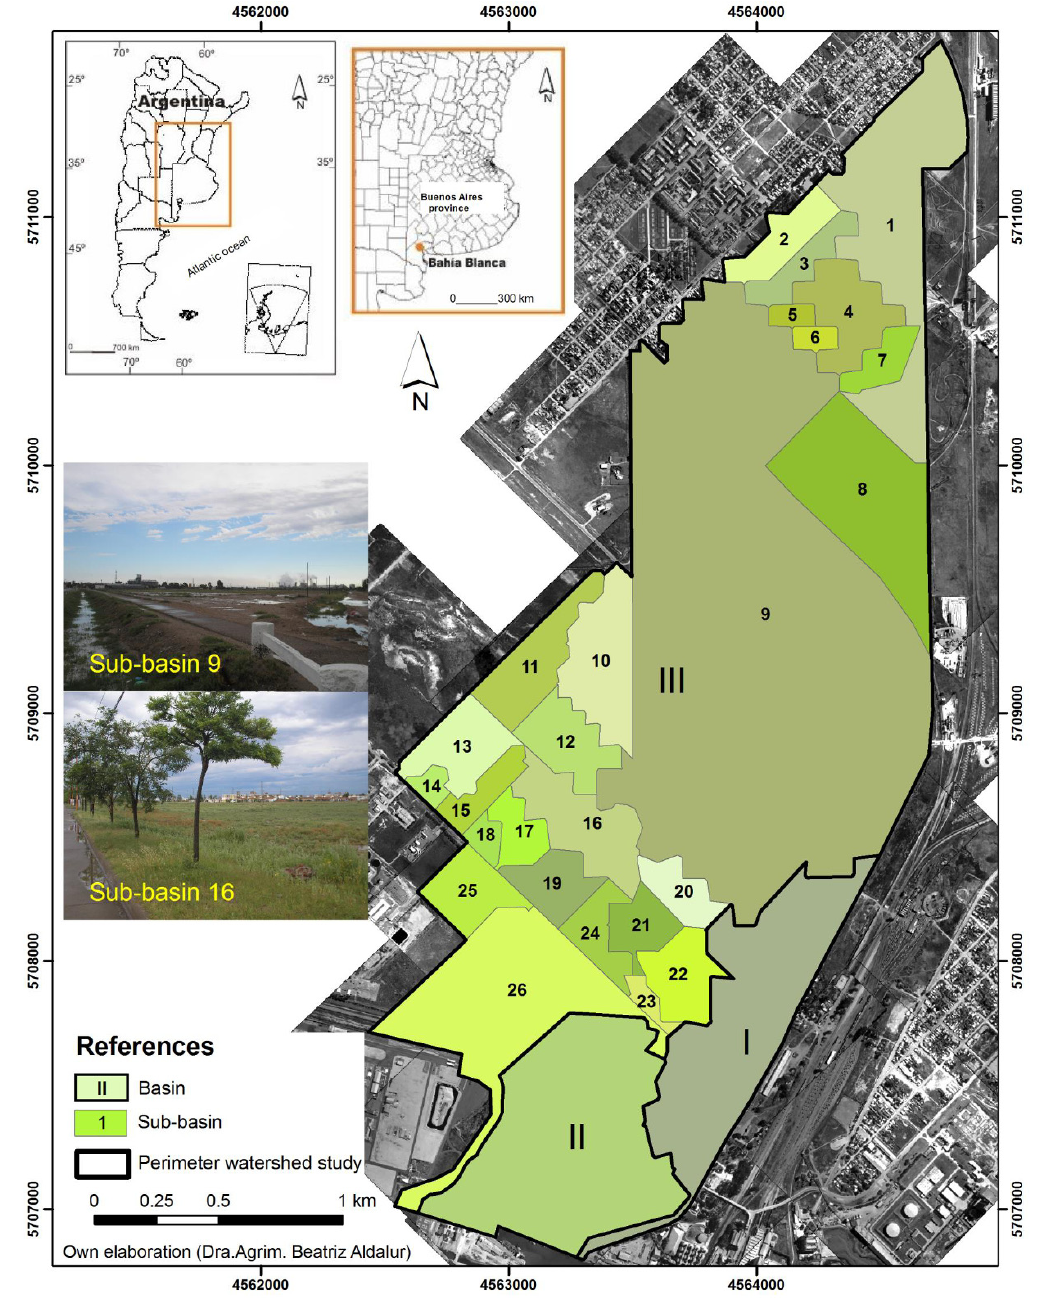
Figure 2. Cartographic representation of the different basins and